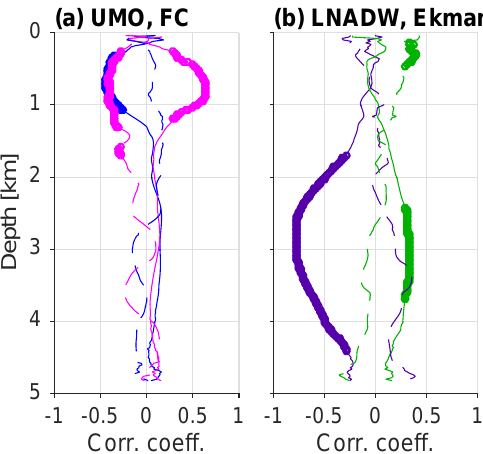
Figure 8. Correlation between isopycnal displacements at each depth and transport time series, where time series are deseason- alized and detrended. (a) Correlation between UMO (magenta) and isopycnal displacements at the west (solid) and east (dashed), and between FC (blue) and isopycnal displacements at the west (solid) and east (dashed). Significant correlations are indicated by the thicker line. (b) The same, but for LNADW (purple) and Ekman (green).